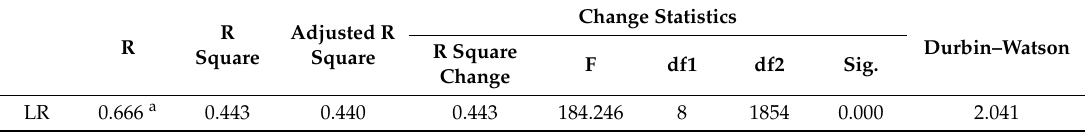
Table 3. Results of linear regression (LR) model for modeling log (STIR), continental US.